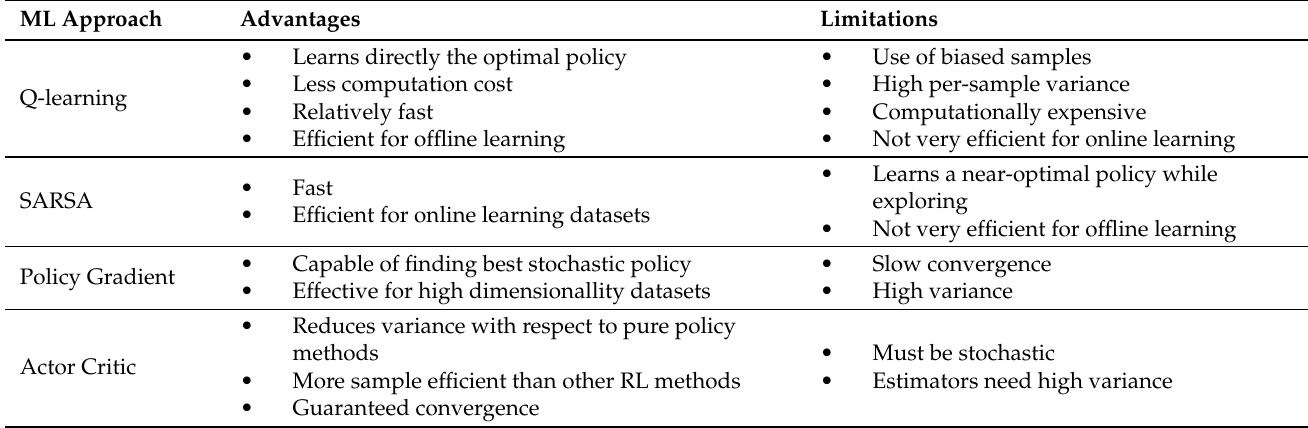
Table 4. Advantages and limitations of RL